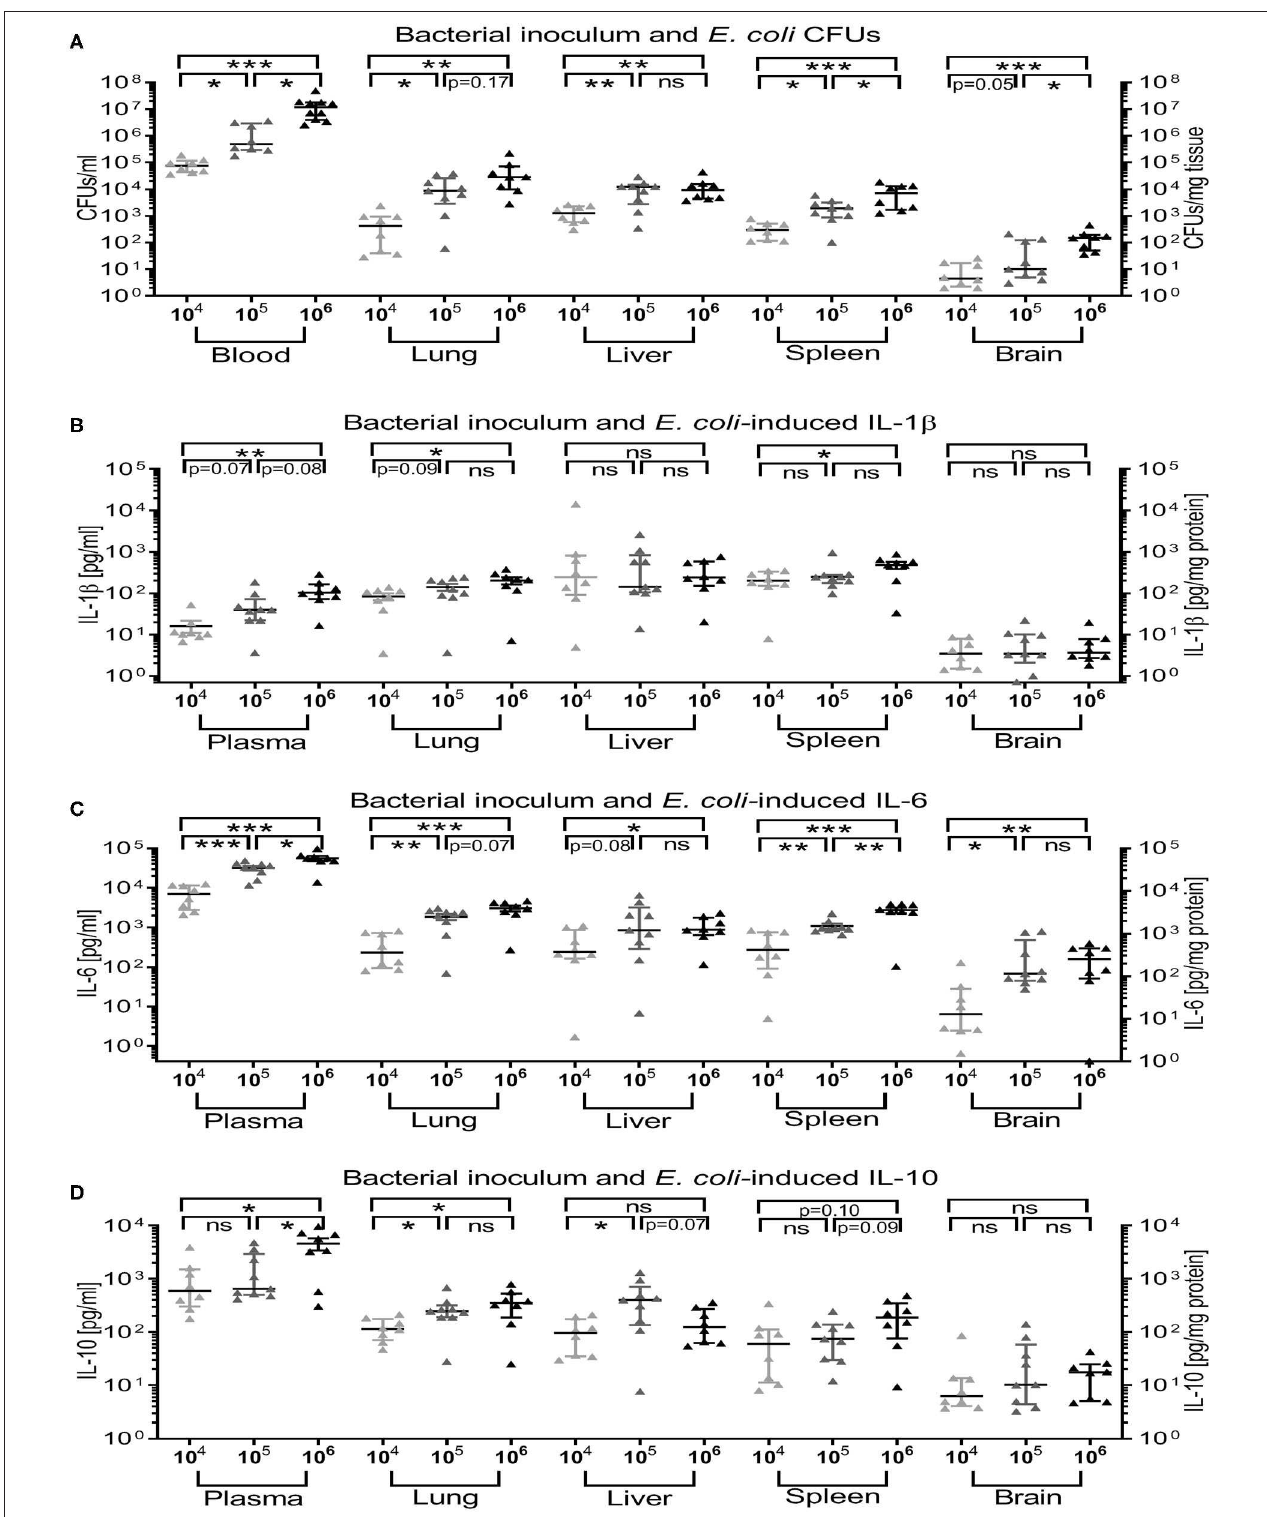
FIGURE 5 | Recovery of E. coli CFUs and magnitude of cytokine production in blood and organ tissue was inoculum-dependent. Neonatal mice < 24h old were injected IV with E. coli 10 4 , 10 5 , or 10 6 CFU/g body weight suspended in saline with 0.05% Evans blue. After 4h of incubation, mice were euthanized and blood, and homogenized organ tissue serially plated for bacterial counting, and cytokine concentrations measured. Mean ( ± SEM) or median (IQR) were plotted and one-way